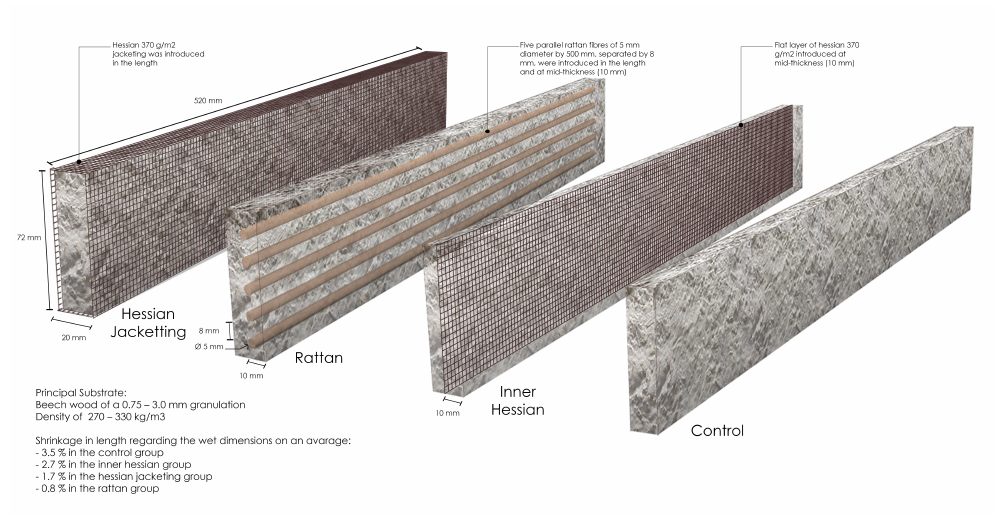
Figure 1. Fibre placement strategies (left to right): hessian jacketing (BM_H), rattan fibres (BM_R), inner hessian (BM_I), control (BM). Table 1. Referenced standards for flexural characterisation in the MBC state-of-the-art.